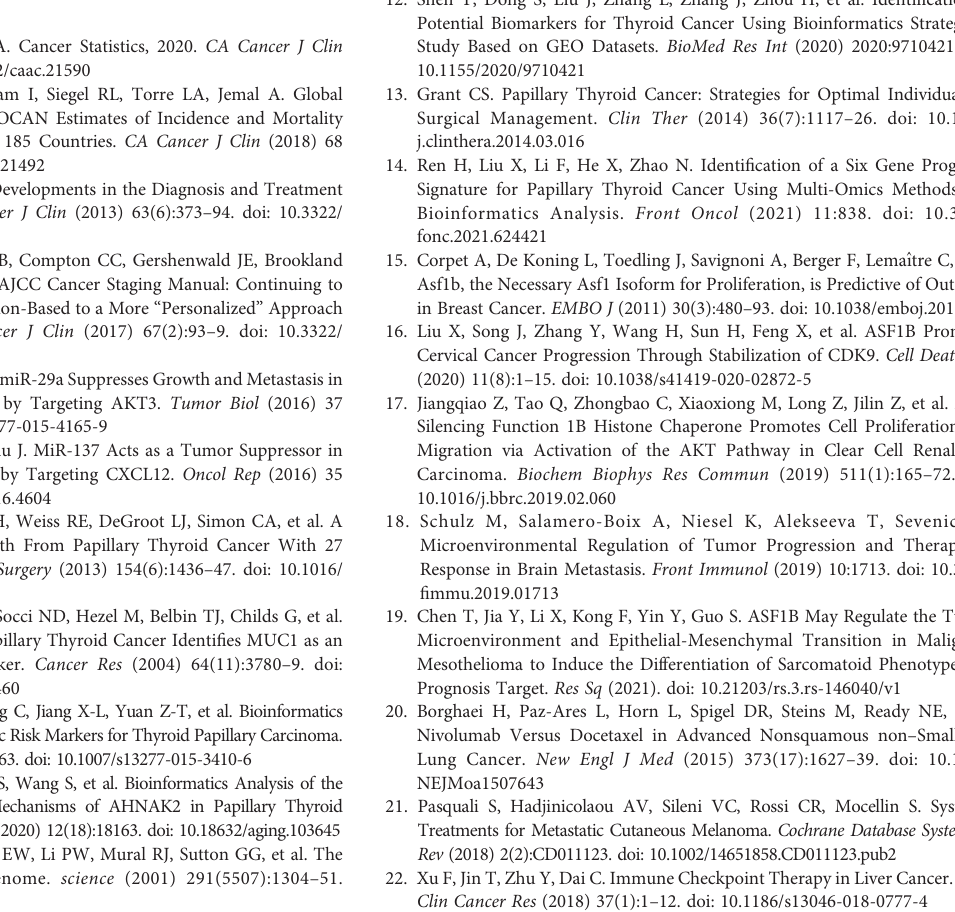
Supplementary Figure 1 | Differentially expressed genes and functional enrichment analysis; (A) volcano plot: black dots indicate signi fi cantly differentially up-regulated genes and yellow dots indicate signi fi cantly differentially down- regulated genes; (B) heat map: differential gene expression heat map, where different colors represent expression trends in different tissues. Supplementary Table 1 | List of datasets. Supplementary Table 2 | The gene lists of DEGs and Genes about